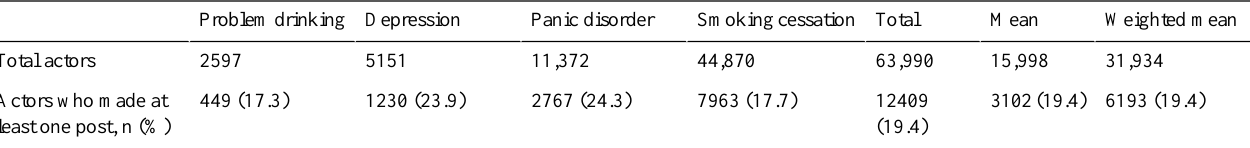
Table 3. Number and percentage of actors making one or more